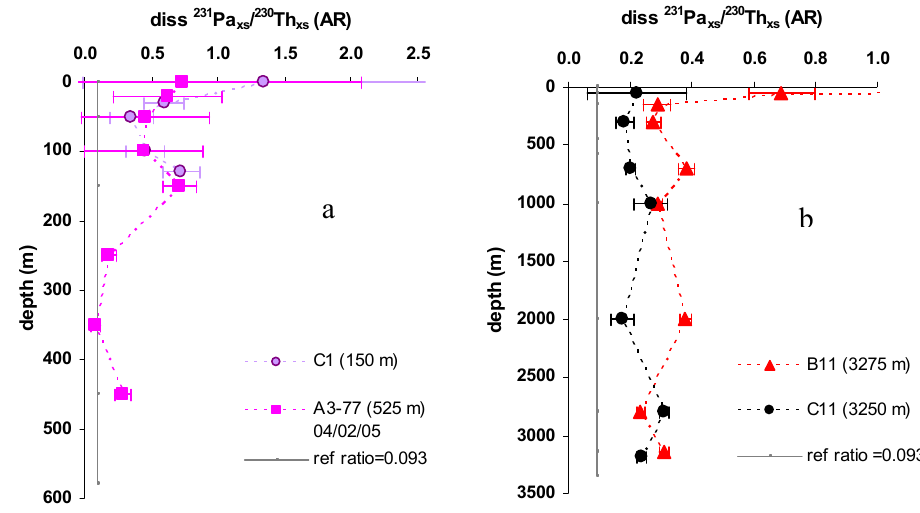
Figures 3A and 3B Fig. 3. Dissolved 231 Pa xs / 230 Th xs activity ratio vertical profiles. (a) on the Kerguelen plateau. (b) off-plateau. The error bars are represented here at the 2 σ uncertainty (as described in Sect. 2.4.3). The grey line represents the 231 Pa/ 230 Th production activity ratio = 0.093. Bottom depths are indicated into brackets. Note that for station B11 the high dissolved ratio (3.03 ± 0.6) at the surface is not represented in this figure.